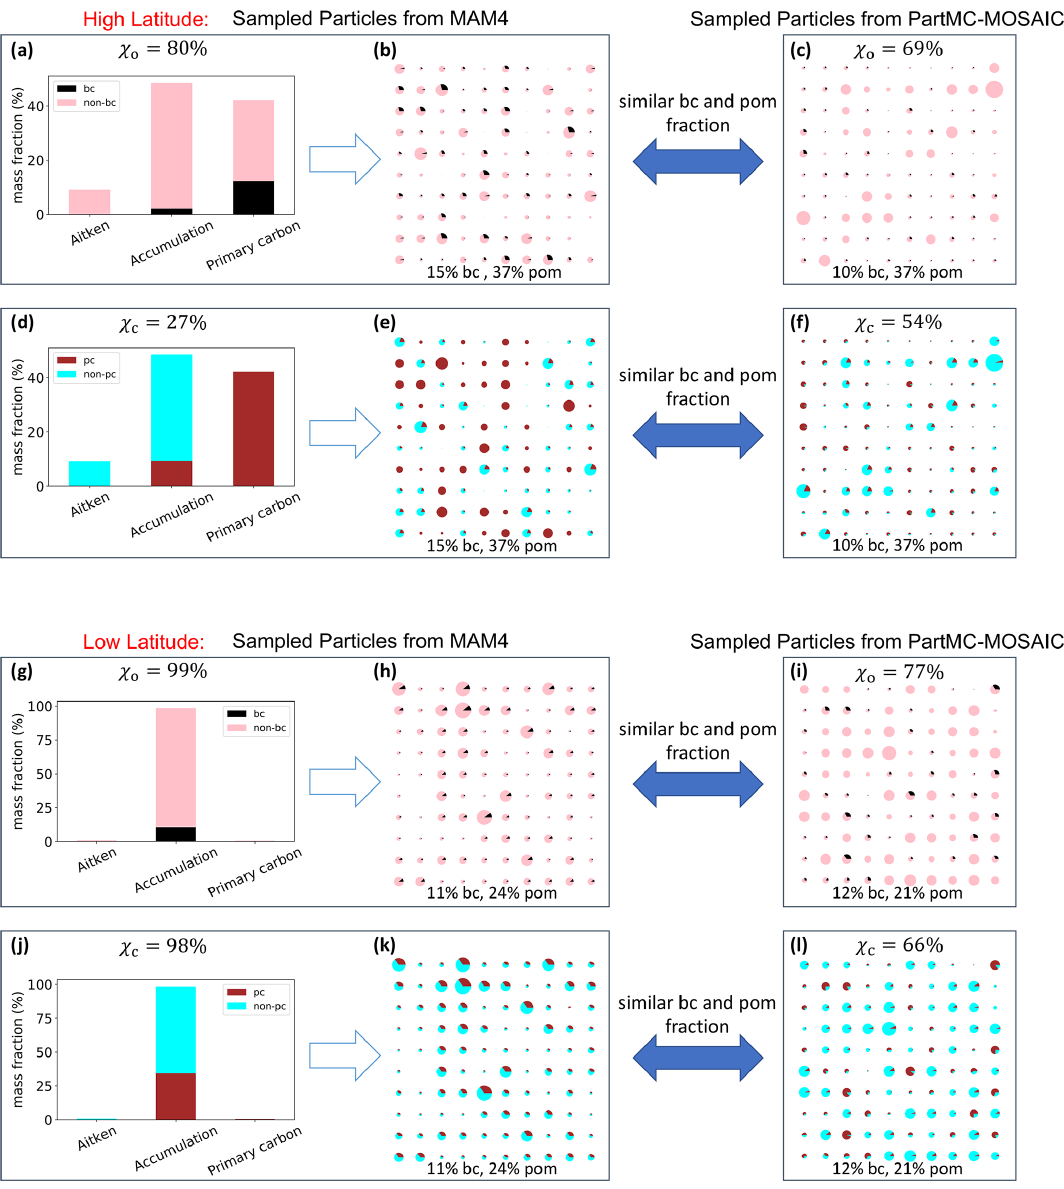
Figure 6. Illustration to explain the differences in mixing state representation between MAM4 and the ML model at high and low